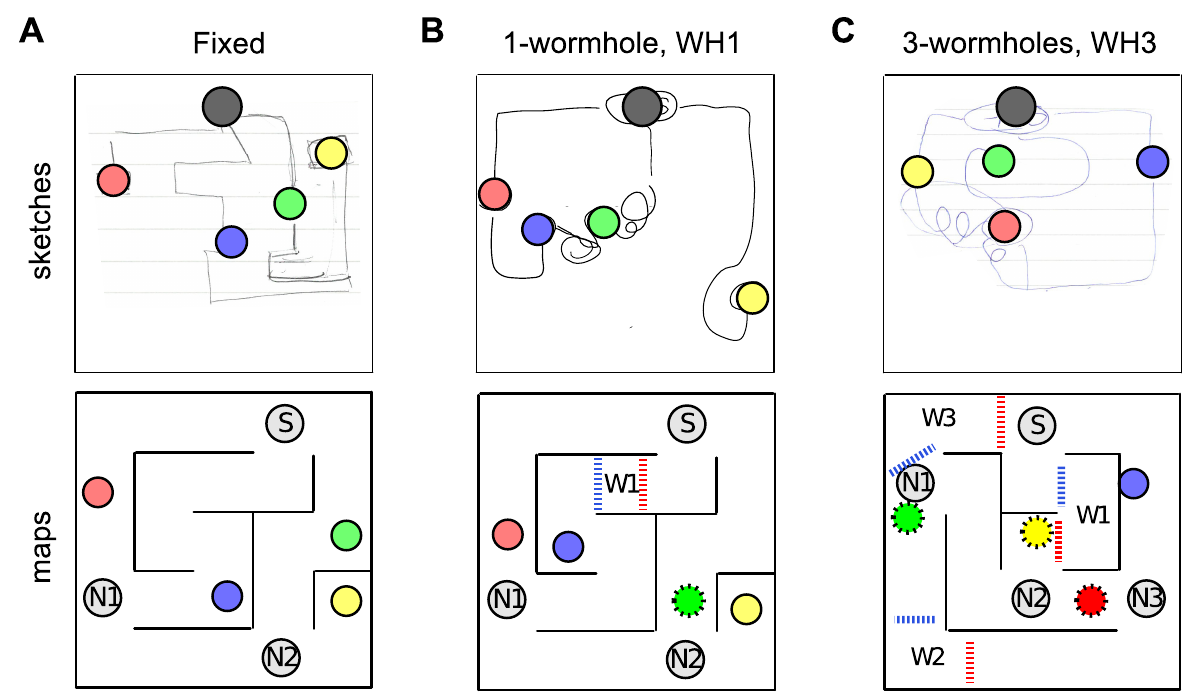
Fig 6. Sketches drawn by participants. The black circle indicates the Start location, coloured circles are the targets (added to the sketches for clarity). A) Fixed condition, Layout 1. Notice that the schematic is very accurate except for scale (e.g. length of the corridor with the Yellow target). B) one-wormhole condition, Layout 1. The Green target was inside a wormhole and, from the squiggles connecting it to other targets, the participant appears to be confused about its location on the map and the shape of the corresponding corridor, while Red, Blue and Yellow targets are sketched correctly. C) Three-wormhole condition, Layout 2. The participant makes large errors in the locations of several targets but demonstrates knowledge of topological properties (connectivity between nodes) of the maze. A and B are from Layout 1, C is from Layout 2. More sketches are included S3 Fig.